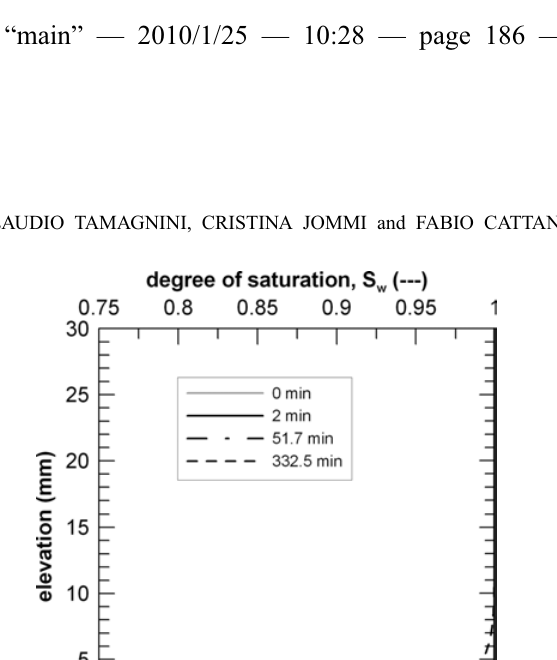
Fig. 11 – Electrokinetic filtration test: isochrones of the degree of saturation computed for The ideal scheme for a one-dimensional electrokinetic consolidation test on a saturated soil specimen is represented in Figure 12.